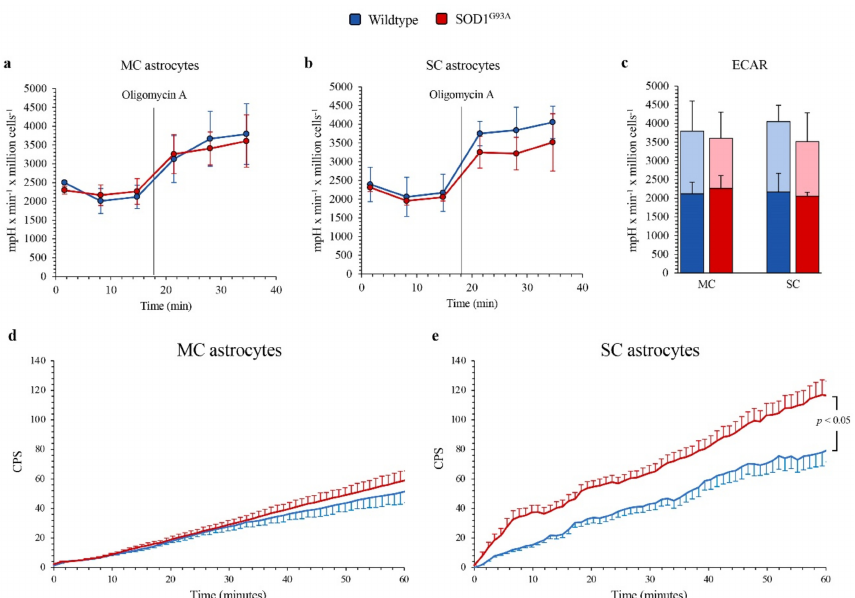
Figure 4. Glycolytic flux and FDG uptake in SOD1 G93A astrocytes. Basal extracellular acidification rate (ECAR) measured in presence of glucose (11 mM), glutamine (2 mM) and pyruvate (1 mM) and after injection of the ATP-synthase inhibitor oligomycin A (1 mM) in ( a ) motor cortex (MC) and ( b ) spinal cord (SC) astrocytes, in wildtype (blue) and SOD1 G93A astrocytes (red). ( c ) Basal (blue and red in wildtype and SOD1 G93A astrocytes, respectively) and maximal ECARs (light blue and pink in wildtype and SOD1 G93A astrocytes, respectively) in MC and SC cells. Average time-course of in vitro radioactivity expressed as a count per second (CPS) of the FDG dose measured by the LigandTracer White device, in MC ( d ) and SC ( e ) astrocytes. Data are shown as the mean ± SD. n = 3 experiments per group, with each value defined in triplicate.